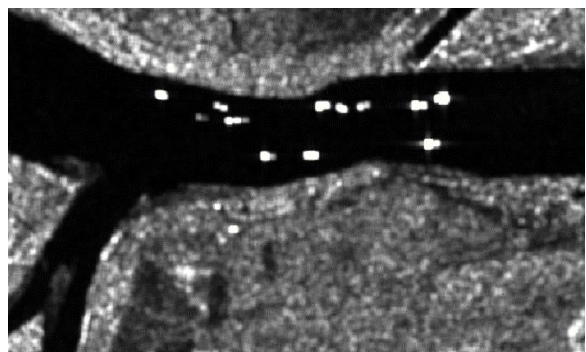
Figure 13 Automatic detection of ships (zoom) - Zimnicea – 09.08.2015 - Sentinel-1A (© Copernicus Sentinel data 2015)